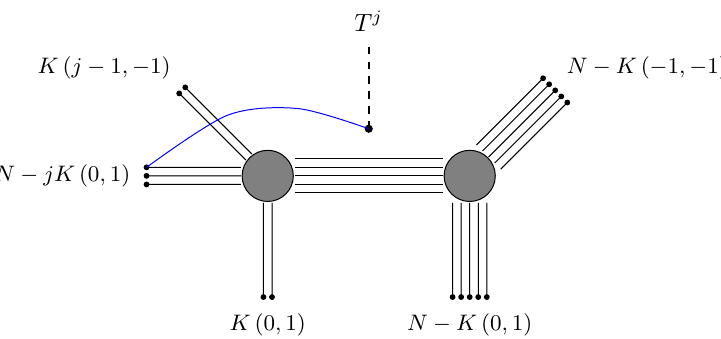
Figure 2 . Brane web obtained from the T N;K;j junction by mass deformation and 7-brane moves, with the fundamental string expected to realize the meson operator shown in blue. The 5-brane numbers and charges are indicated in all-ingoing